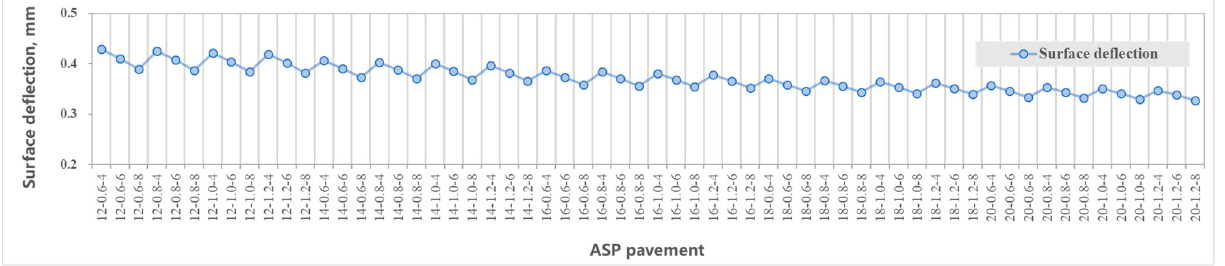
Figure 7. Tensile stress at the bottom of each layer of ASP pavement with different thicknesses.